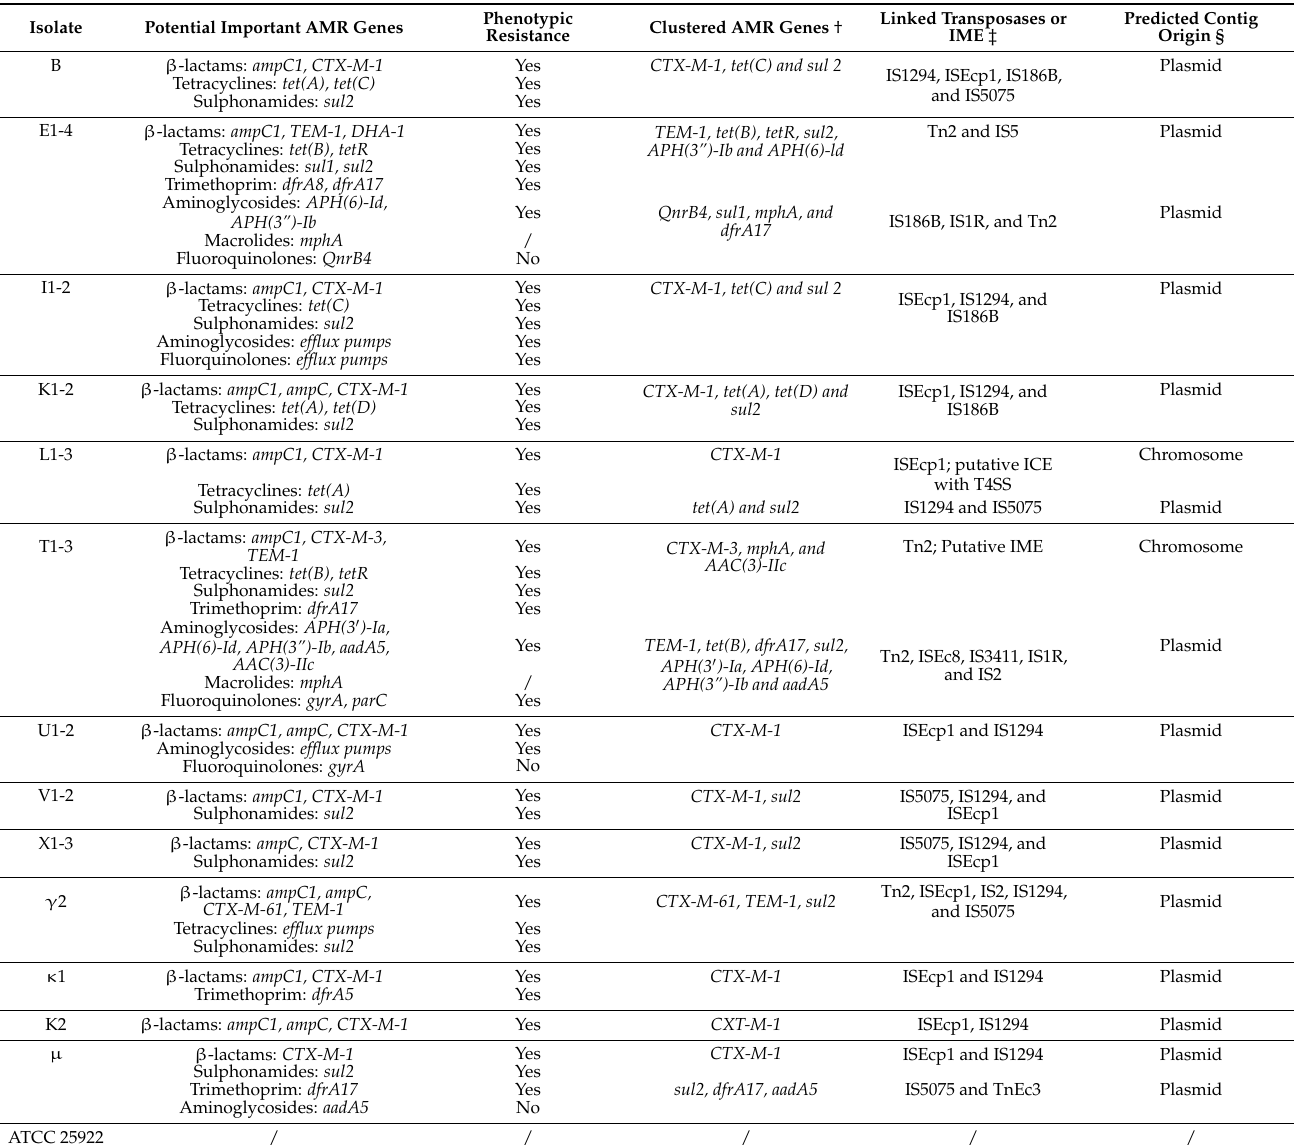
Table 3. Overview, clustering, and localization of AMR genes detected in Escherichia spp. isolates obtained from zoo